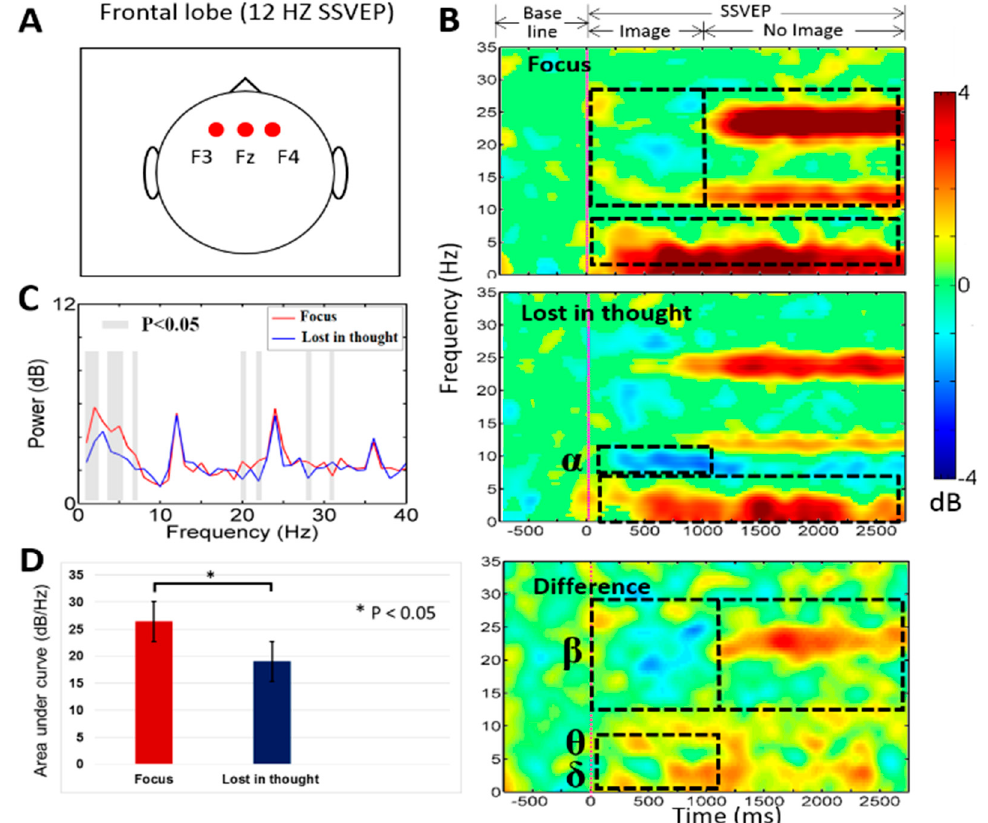
Figure 4. ( A ) Displays electrodes (F3, Fz, F4) location in frontal lobe. ( B ) The event-related spectral perturbation (ERSP) was observed during mental focus and lost-in-thought states at 12 Hz SSVEP flicker frequency. The pink vertical line shows the stimulus onset. Statistic at p < 0.05. Color bar indicate the scale of significant ERSP in decibel (dB). ( C ) The power spectral density (PSD) for the mental focus state (red line) and lost-in-thought state (blue line). The grey areas represents statistically pairwise significant di ff erence ( p < 0.05) in t -test between mental focus and lost-in-thought states. ( D ) The area under curve (AUC) was measured in mental focus and lost-in-thought states (*p < 0.05).